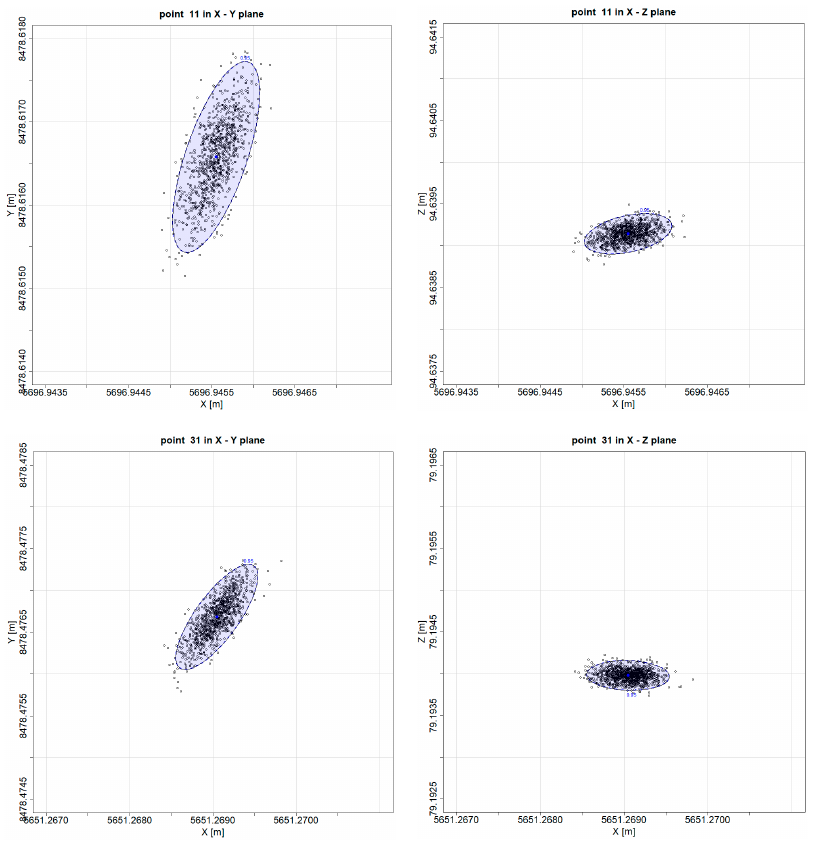
E ff ects of limited knowledge on atmospheric